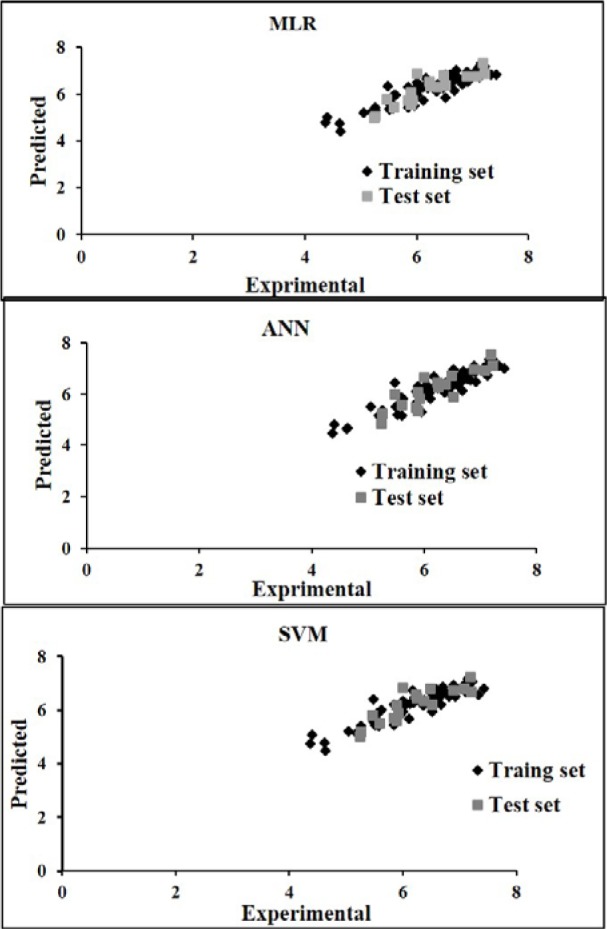
Experimental versus predicted pIC50 values using MLR, ANN and SVM models